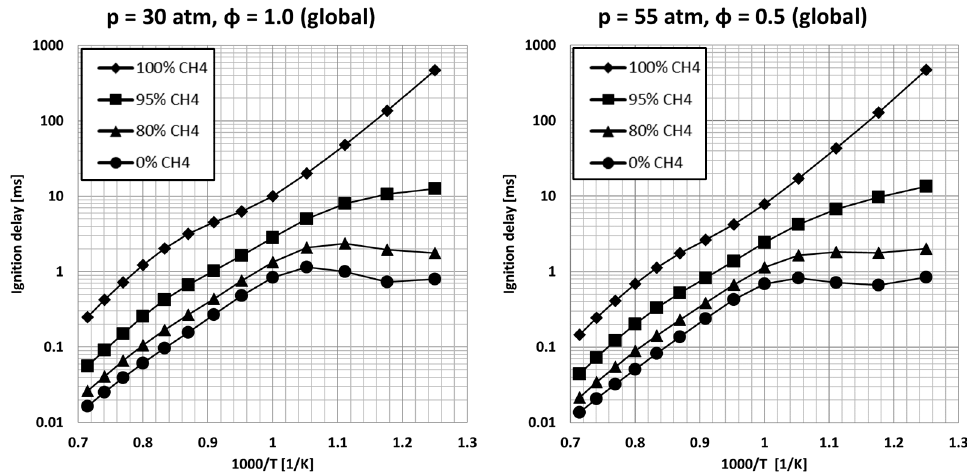
Figure 3. Ignition delay times with different fuel blends of n-heptane and methane at fixed global equivalence ratios and pressures.